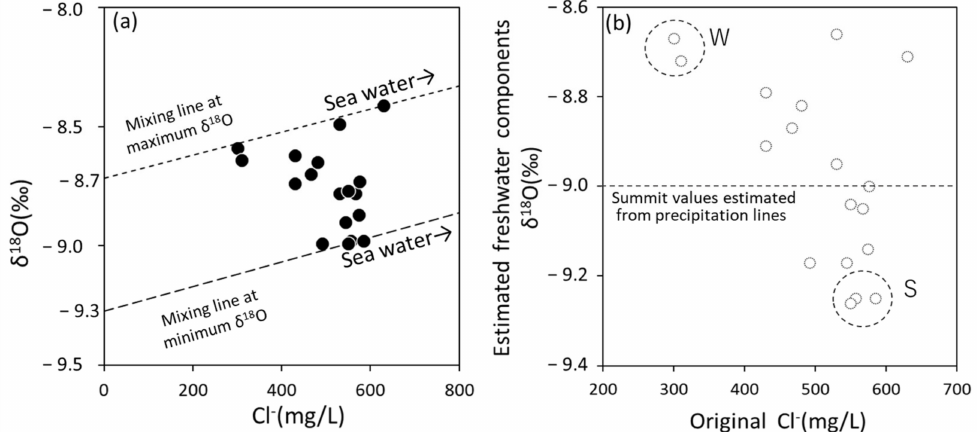
Figure 5. ( a ) Relationship between the Cl − concentration and δ 18 O at G3-30. ( b ) Relationship between the original Cl − concentration and δ 18 O of the estimated freshwater